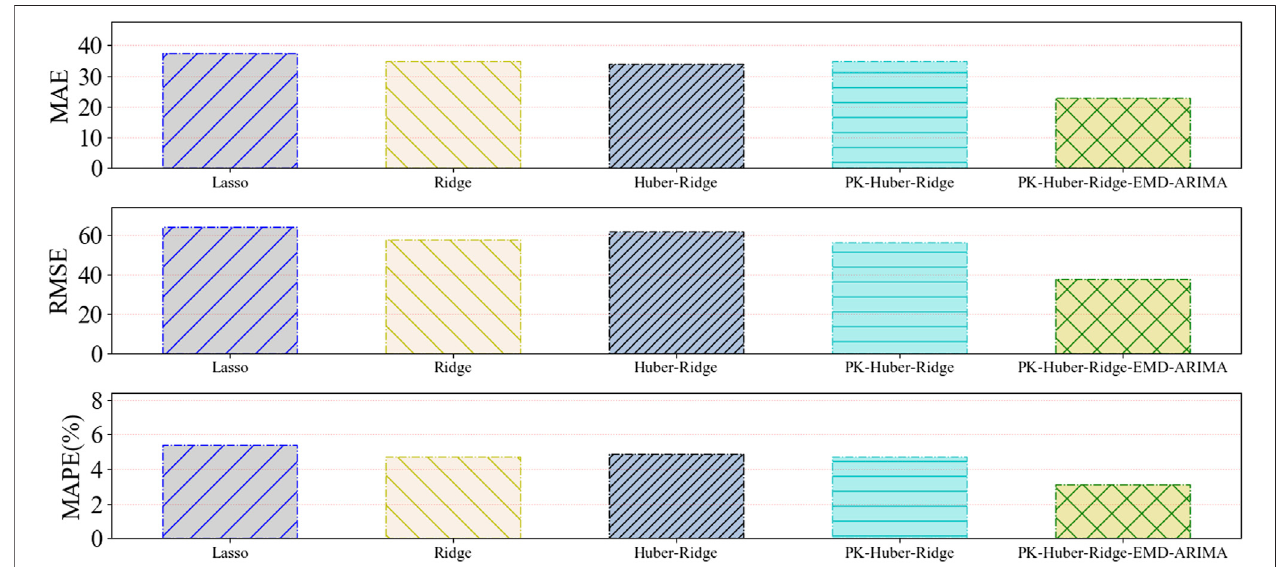
FIGURE 5 | A histogram of the predictive evaluation index values based on dataset 3 for fi ve types of forecasting models.